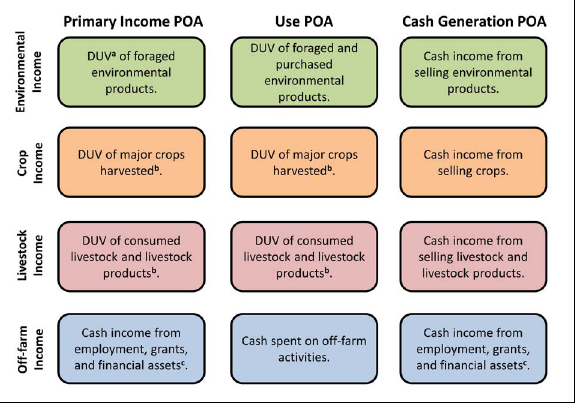
The four income streams (environmental, livestock, crop, off- farm) at three points of analysis